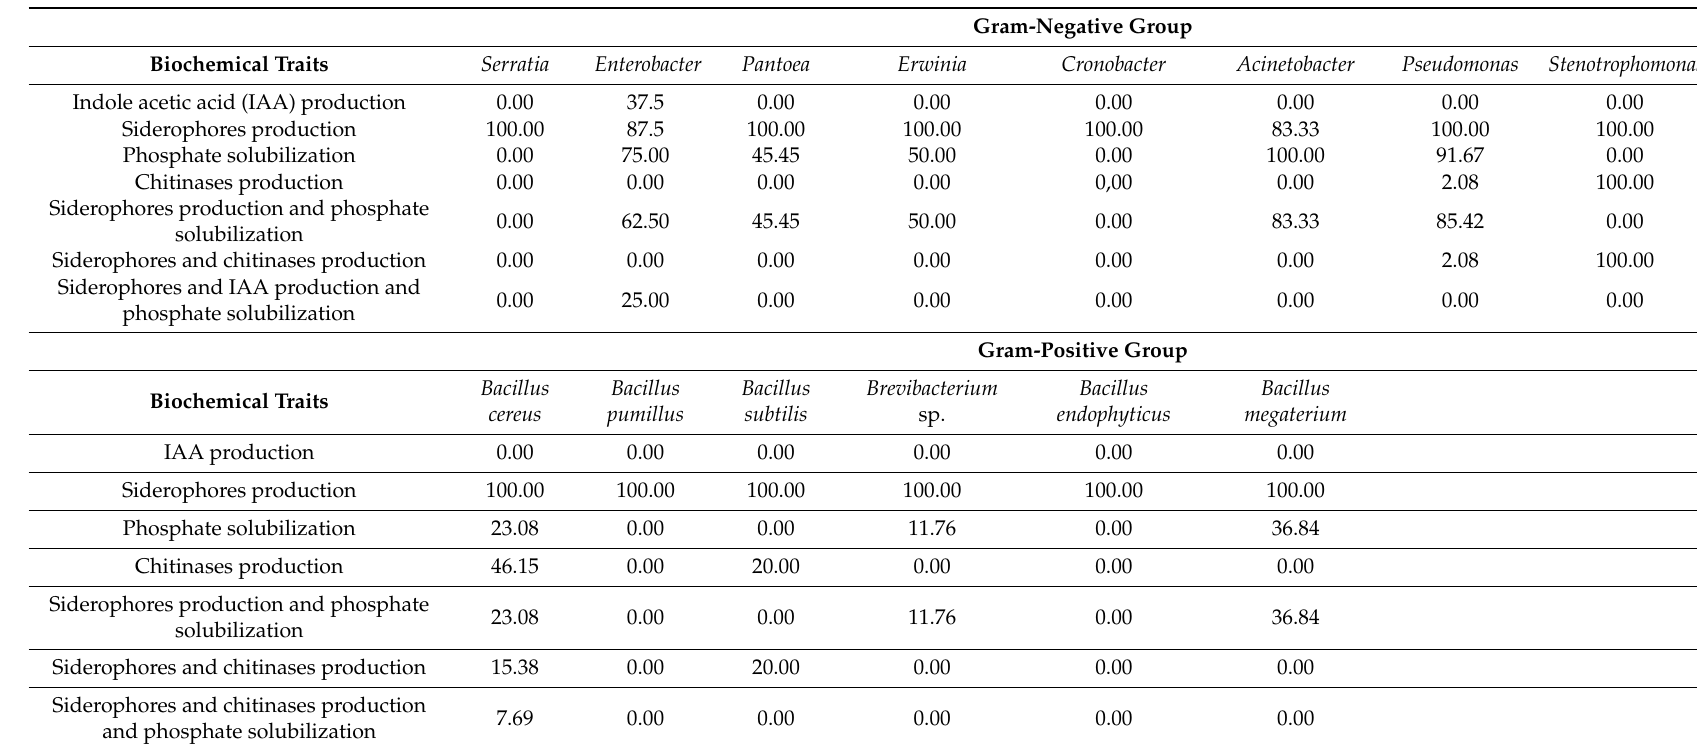
Table 1. Percentage of bacteria within each genera or species (in Gram-positive group), positive for biochemical traits. Gram-Negative